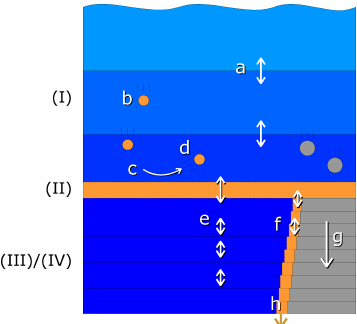
Figure 2. Schematic view of the compartments and vertical ex- change processes in the model. Compartments: (I) water column, (II) fluff layer, (III) pore water, (IV) solid sediment. Both the water column and sediment consist of several vertically stacked grid